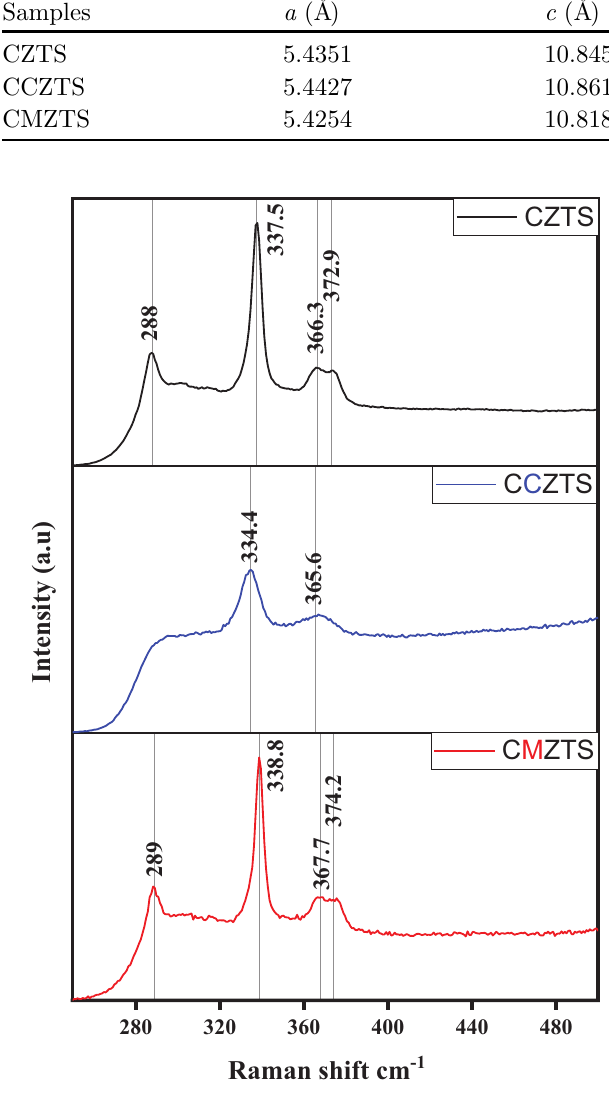
Fig. 3. Raman spectra for CZTS, CCZTS and CMTS